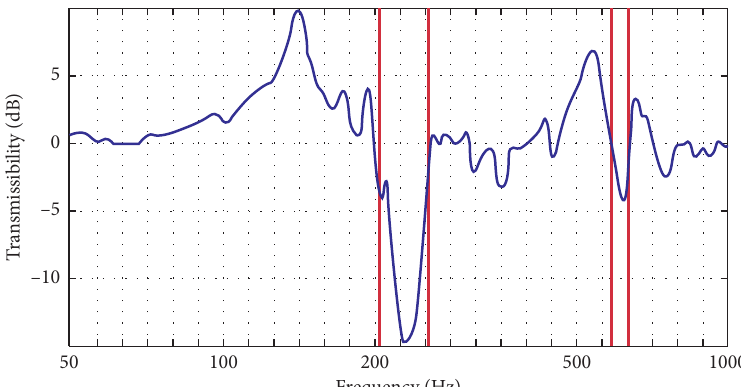
Figure 9: Vibration transmissibility versus frequency for the metamaterial structure obtained using experiment. Measured frequency bandgaps (marked in red) are